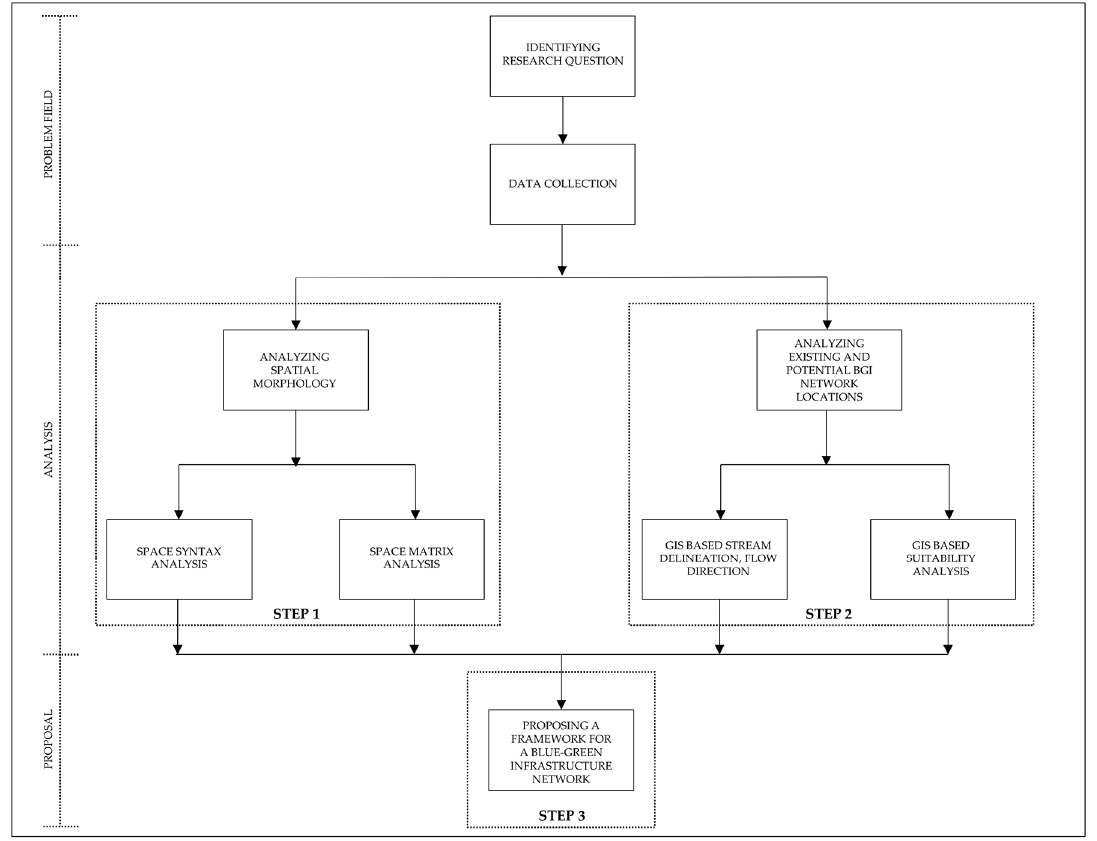
Figure 3. A graphical framework to represent our methodological approach.